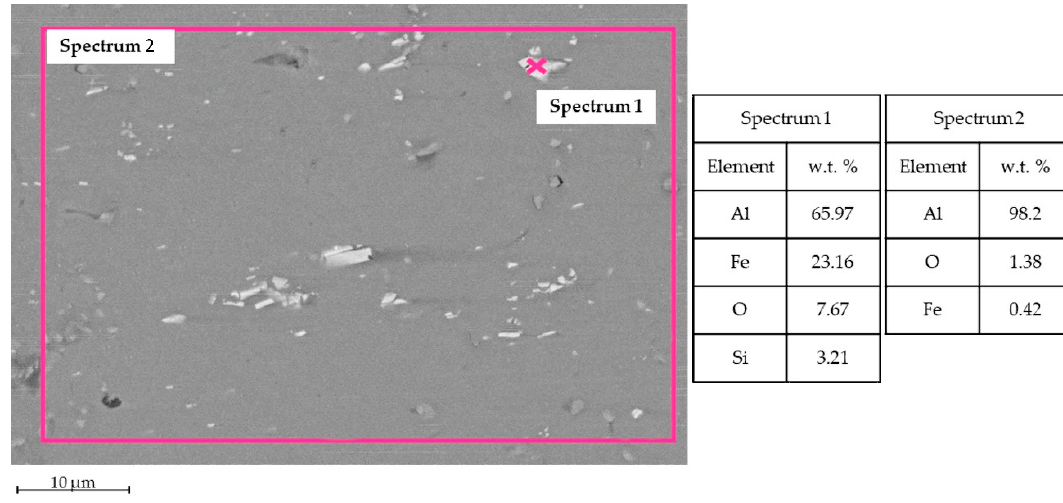
Figure 10. Base metal (BM) AA1070 H16.